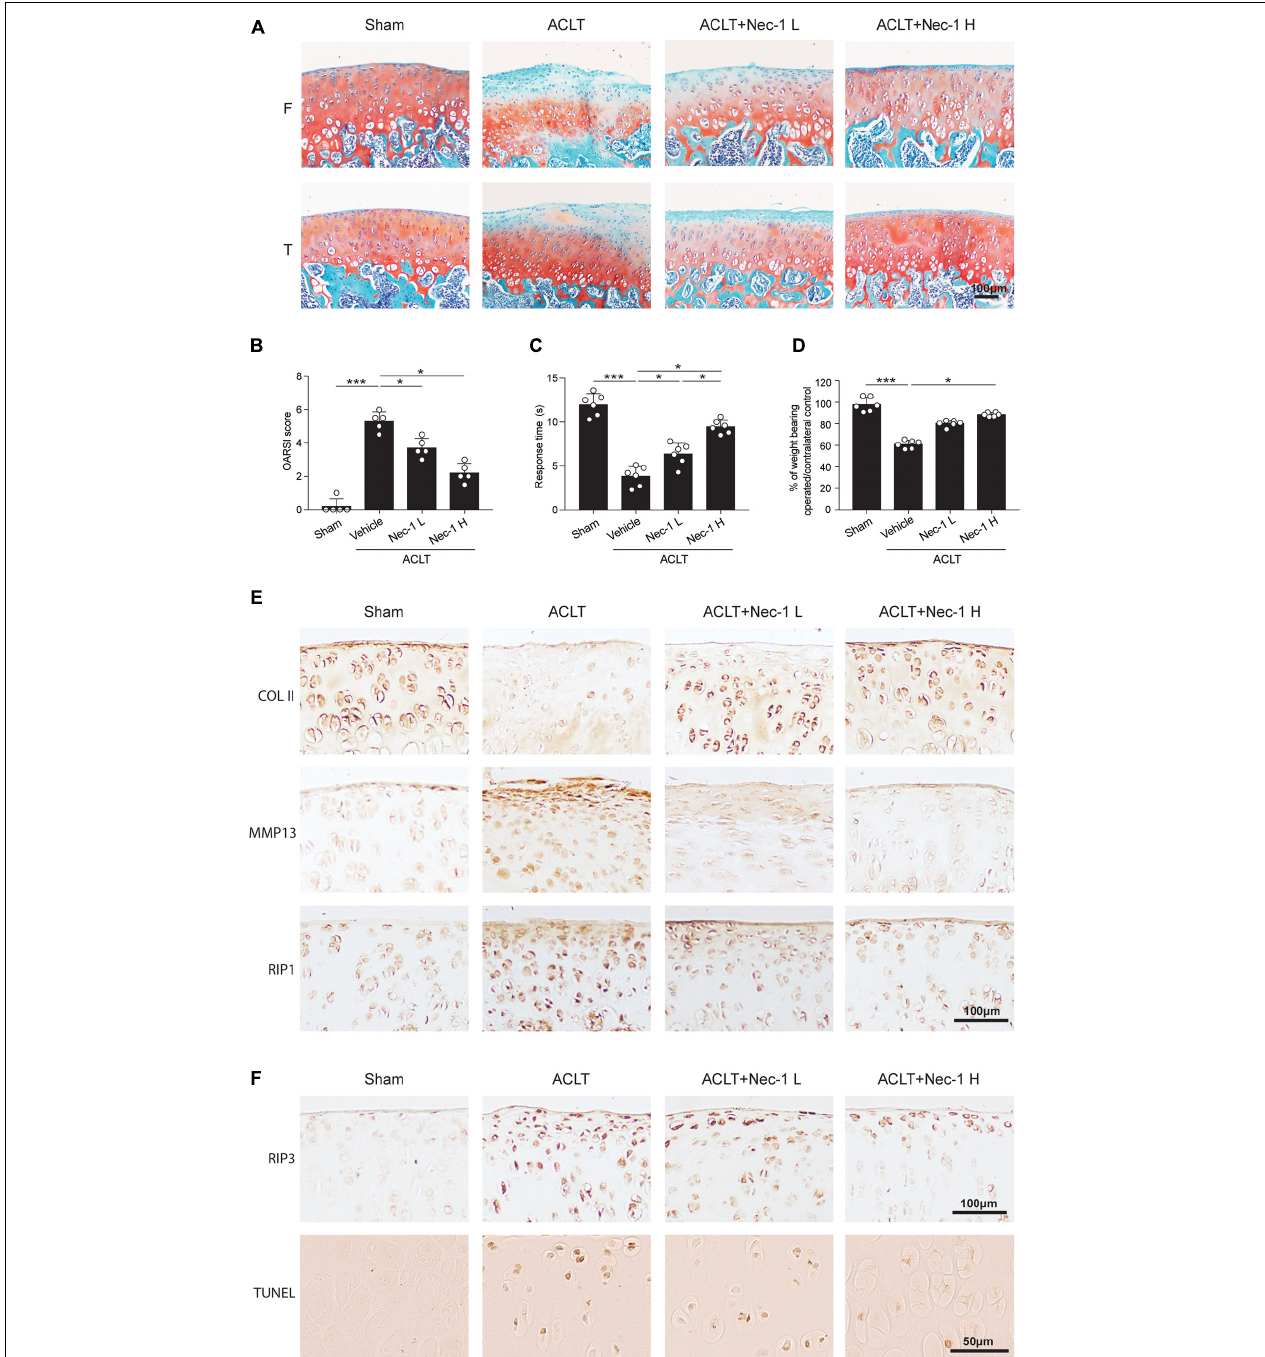
FIGURE 6 | Inhibition of RIP1 enzymatic activity by Nec-1 blocks OA cartilage destruction and the related pain. (A,B) Safranin O and fast green staining (A) and the corresponding OARSI scores (B) of the cartilage from rats with sham or ACLT surgery following by intra-articular injection of vehicle control or two different doses of Nec-1 (0.025 and 0.05 mg/kg) ( n = 5 for each group) F, femur; T, tibia. (C) The pain response times for the rats of each group when placed on the 55 ◦ C hotplate meter ( n = 6 for each group). (D) The ratios of weight placed on the operated hindlimb vs. that on the contralateral sham hindlimb for the rats of each group ( n = 6 for each group). (E) COL II, MMP13, and RIP1 immunostaining of the cartilage from rats with sham or ACLT surgery following by intra-articular injection of vehicle control or two different doses of Nec-1 (0.025 and 0.05 mg/kg) ( n = 5 for each group). (F) RIP3 immunostaining and TUNEL staining of the cartilage from rats with sham or ACLT surgery following by intra-articular injection of vehicle control or two different doses of Nec-1 (0.025 and 0.05 mg/kg) ( n = 5 for each group). * P < 0.05, and *** P < 0.001.